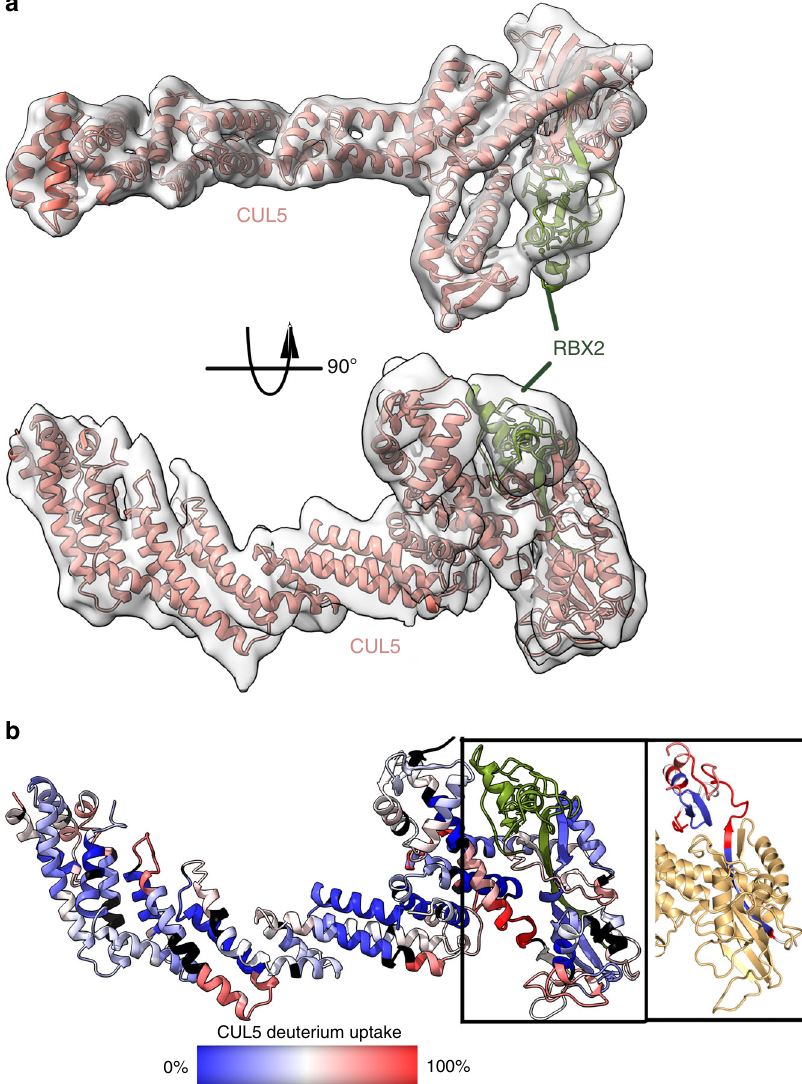
Fig. 2 Structure of full-length CUL5-RBX2 complex. a Cryo-EM map of CUL5-RBX2 shown with the molecular model of CUL5 bound to RBX2. Model was built from crystal structures of CUL5 NTD (4JGH) and CUL5 CTD + RBX1 (3DPL). b Model of CUL5-RBX2 showing the amide exchange results from the HDX- MS data. The exchange after 2 min varied from 0% (blue) to 100% (red). Regions that were not covered in the HDX-MS data are colored black. c The amide exchange after 2 min for RBX2 is displayed on the same color scale as for CUL5.